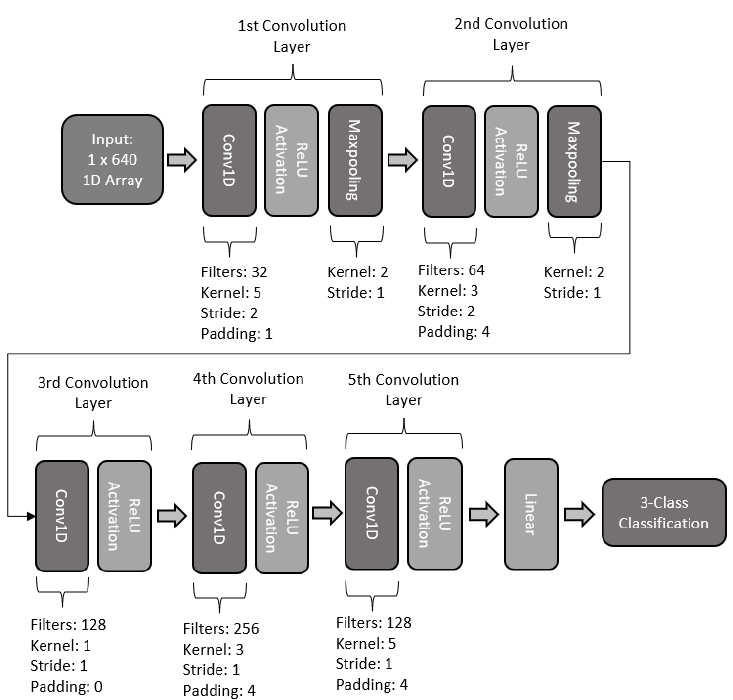
Figure 19. Architecture of five-layer 1D CNN